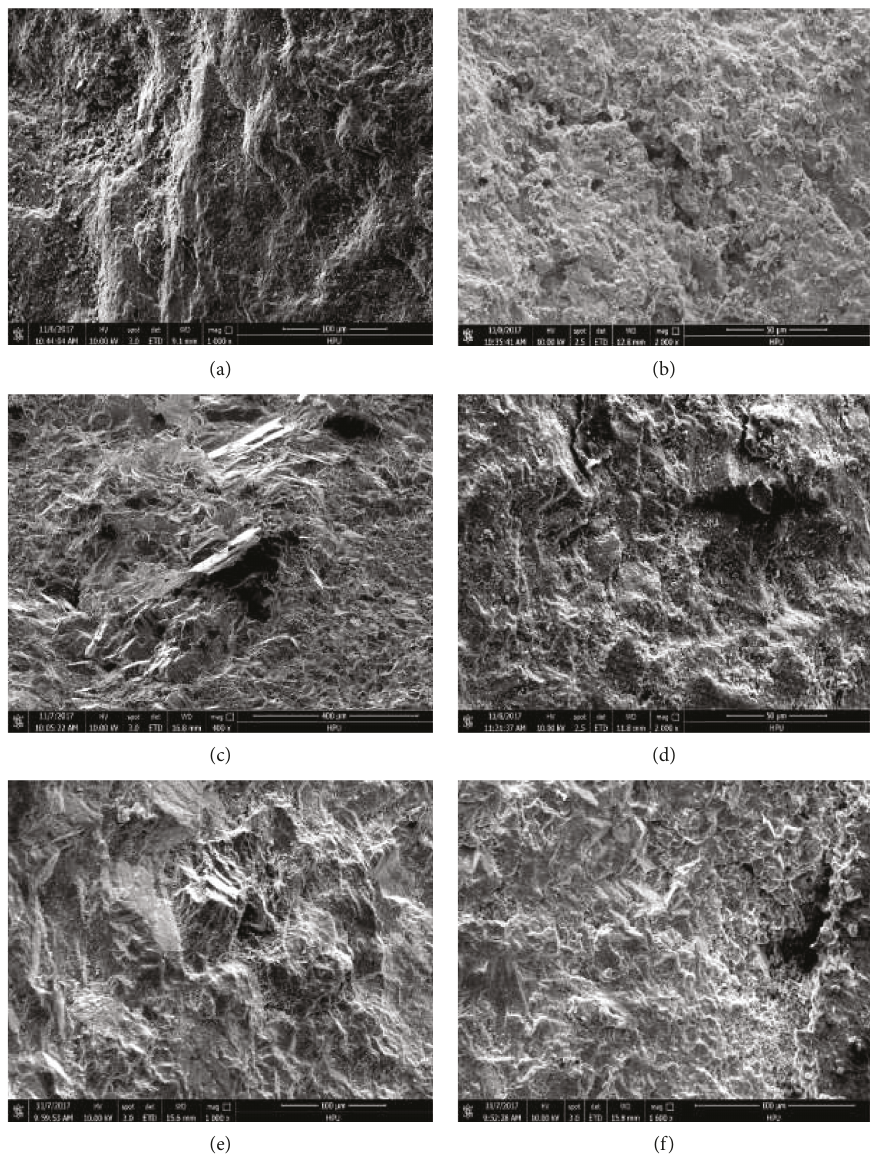
Figure 12: SEM images of the side and bottom of the erosion